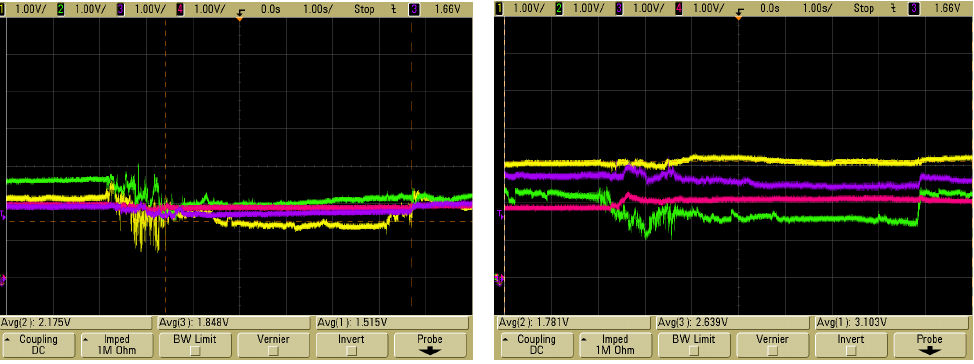
Figure 27. Response of strip 1 and 2.